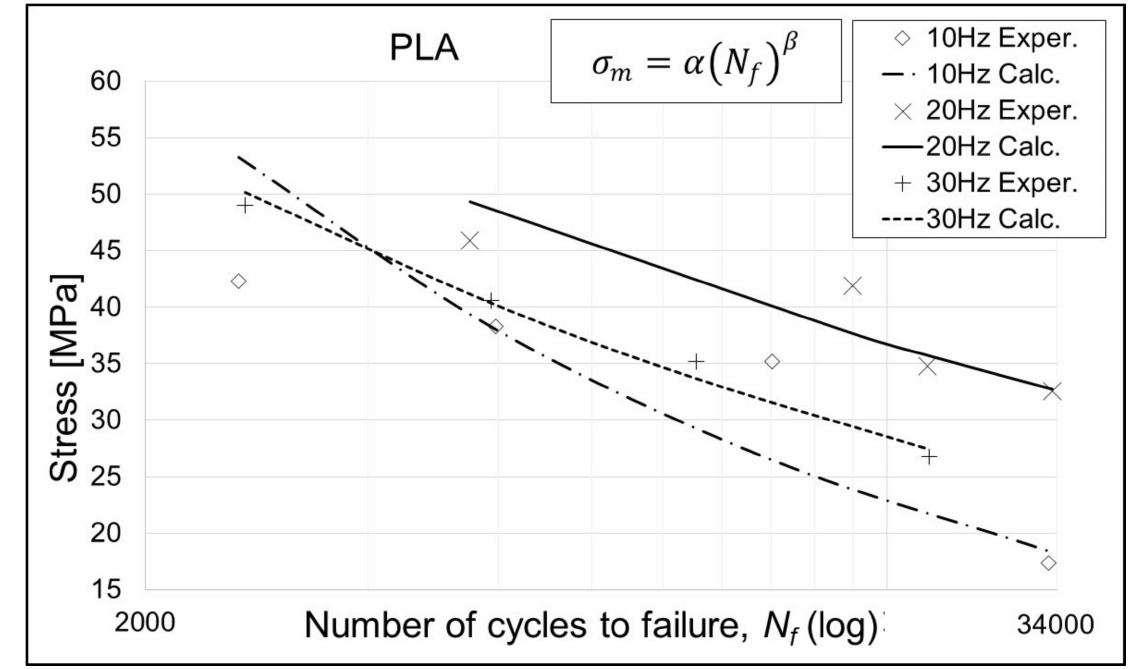
Figure 4. S–N curves for PLA specimens. Exper.—Experimental; Calc.—Calculated.